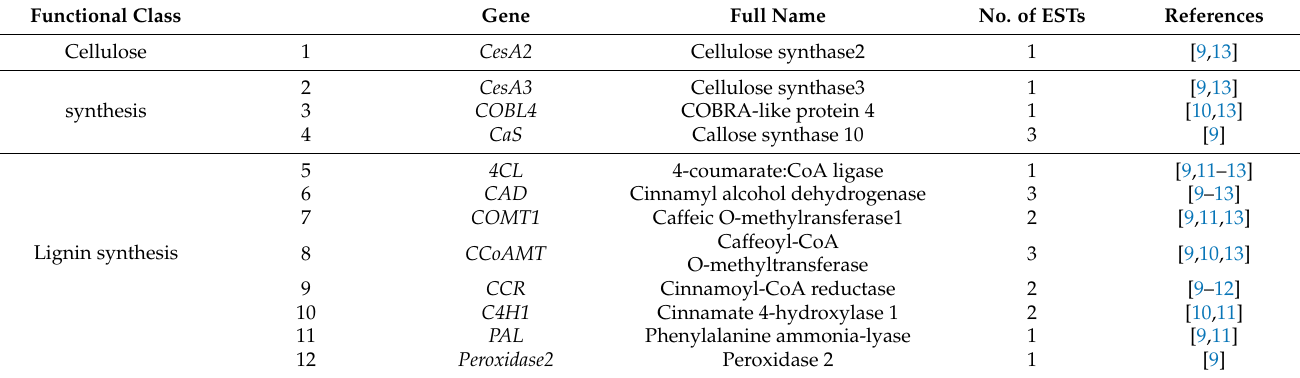
Table 4. Candidate genes for secondary growth development used in the